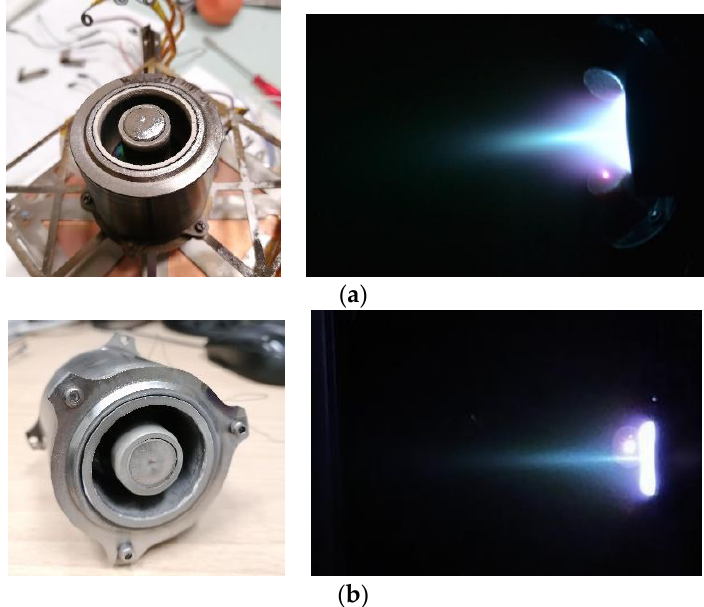
Figure 7. Low-power Hall thrusters operating with Xe: ( a ) 25 W-class; ( b ) 50 W-class.